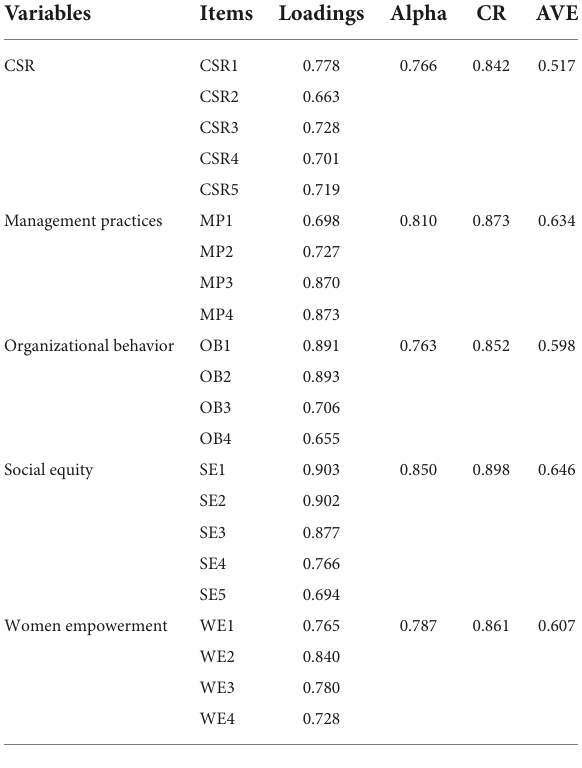
TABLE 1 Factor loadings, composite reliability (CR), and average variance extracted. Variables